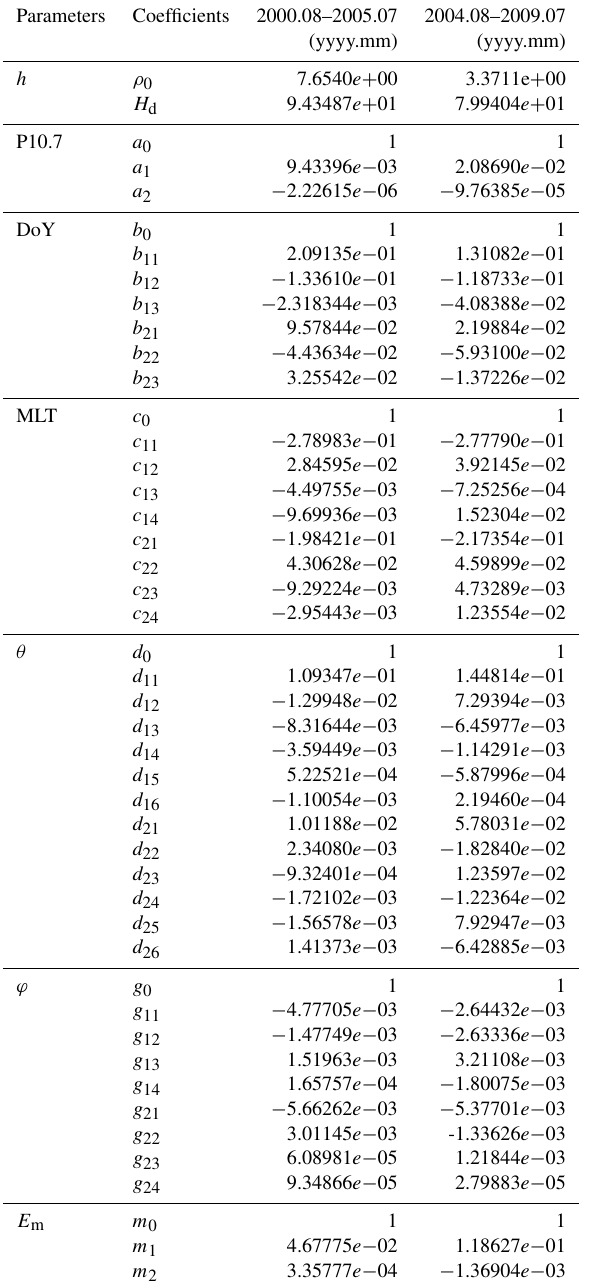
Table 1. The derived values of parameters as defined in Eqs. (4) to (10) for constructing the CH-Therm-2018 empirical model.